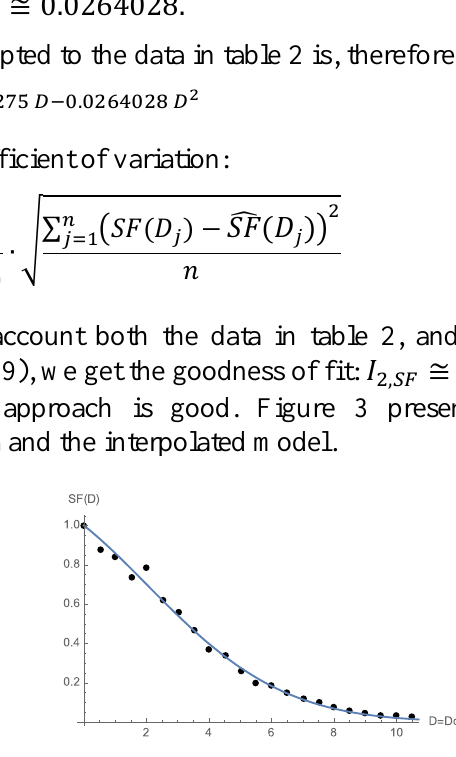
Figure 3: the graph shows the link between the radiant dose and the fraction of surviving individuals (19). The points represent, in Cartesian coordinates, the data of table 2. We put on the D -axis the radiant dose, on the ordinate axis the survival rate SF ( D